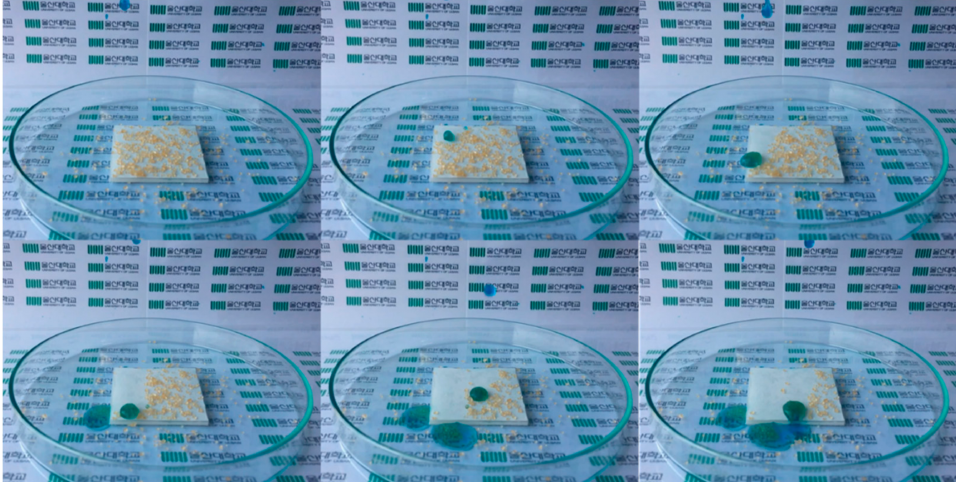
Figure 13. Time sequential images of self-cleaning on the fabricated superhydrophobic PP/SNPs films.